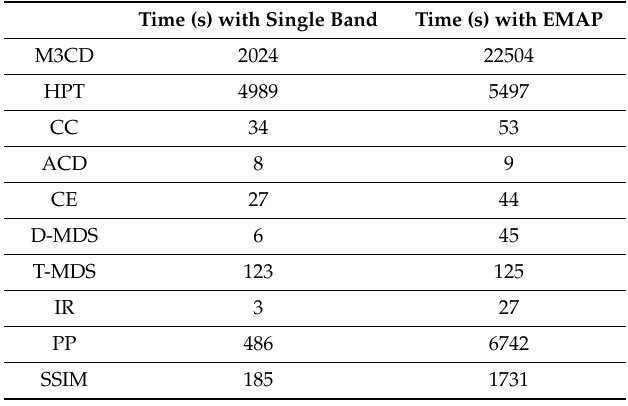
Table 8. Comparison of computational times of the ten algorithms for